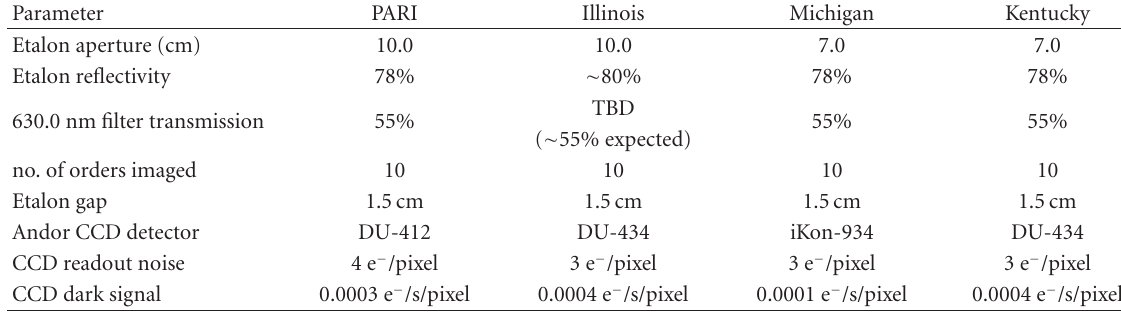
Table 1: Instrument parameters for the initial FPIs to be used in this network.